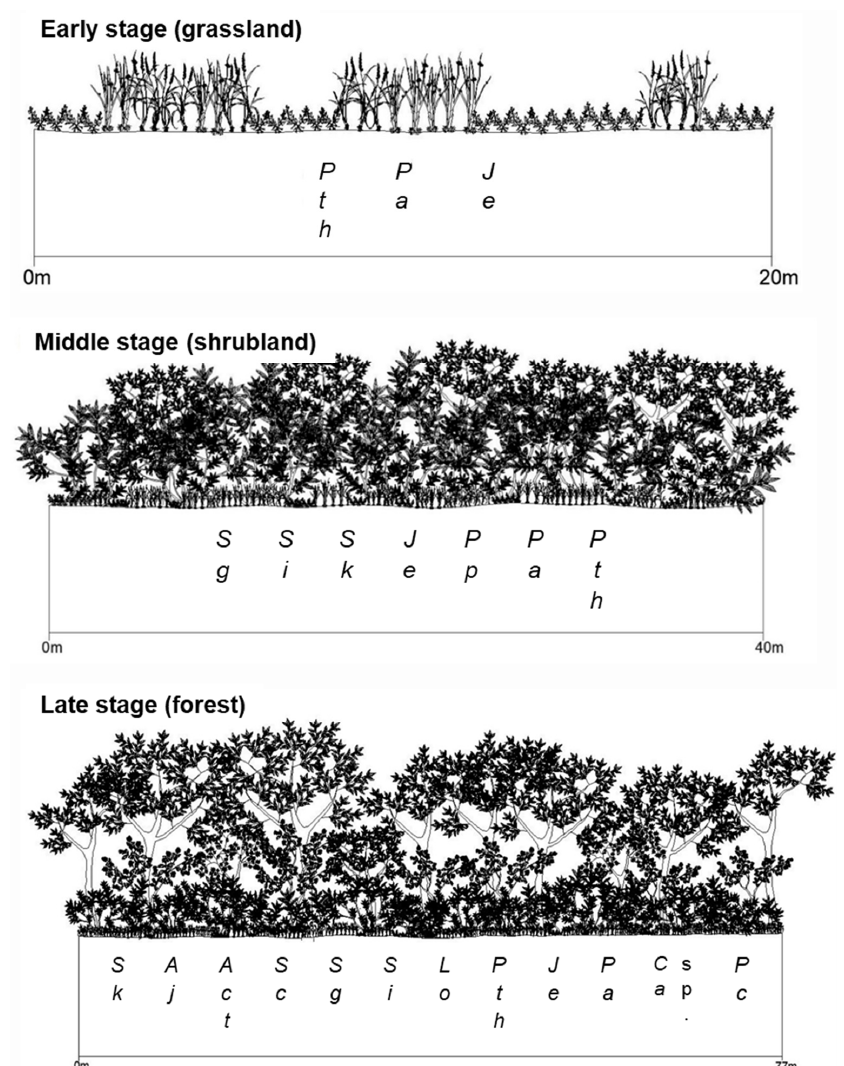
Figure 3. Stand profiles of vegetation investigated in the abandoned rice fields with different history